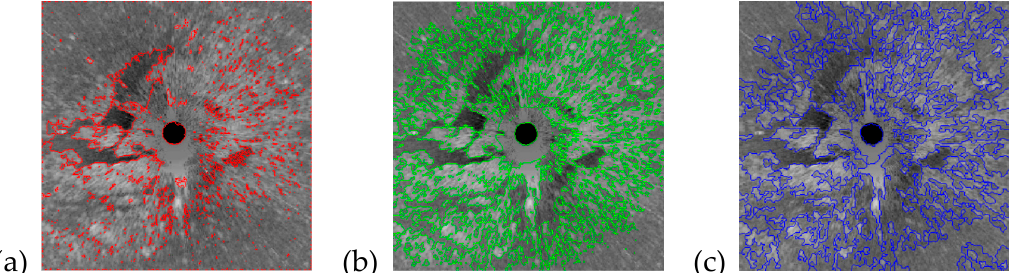
Figure 21. Additional results of various ACMs: ( a – c ) LBF, LGIF, and LIF model results, respectively.